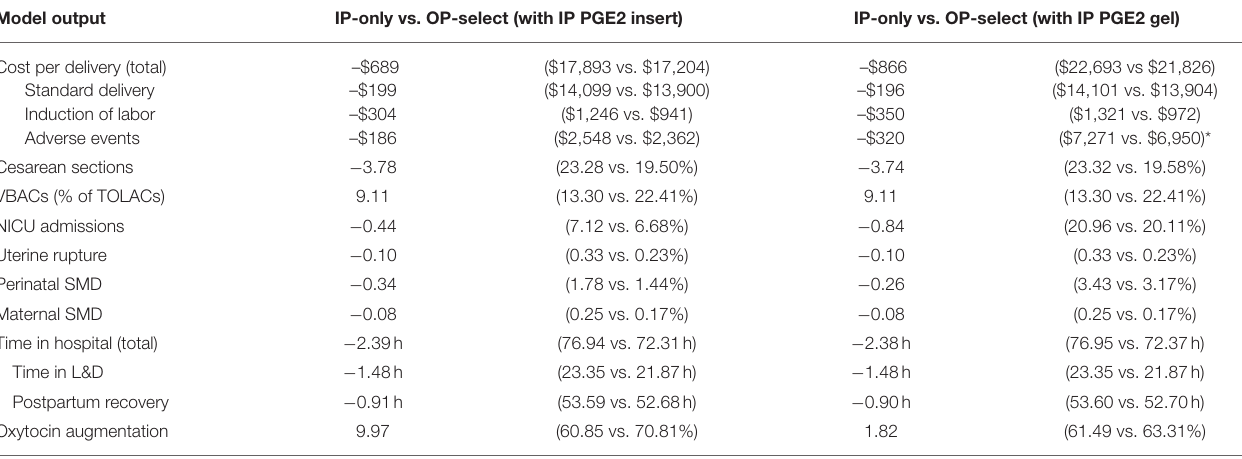
TABLE 3 | Model cost and clinical outcomes in the base case comparing IP-only with OP-select strategies. Model output